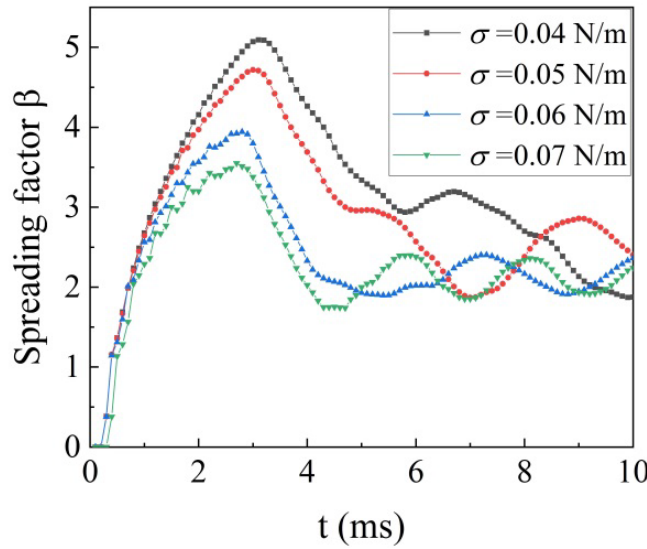
Figure 9. Time evolution of droplet-spreading factors with different surface-tension coefficients ( V = 1.5 m/s, T s = 500 K, D 0 = 1 mm, and θ = 100°).